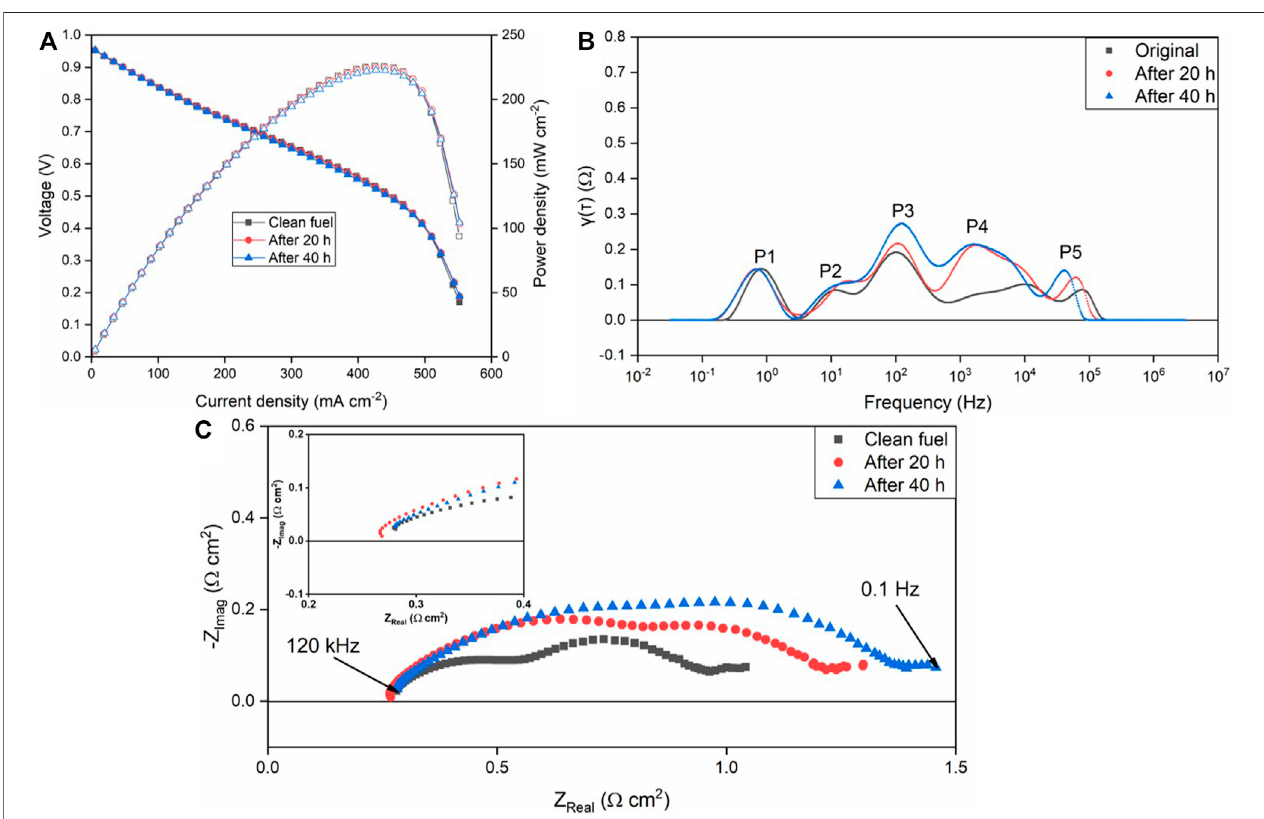
FIGURE3| PerformancedegradationoftheSOFCduetoL4contamination withH 2 +N 2 +L4asthefuelat750 ° C. (A) polarizationcurve; (B) EISmeasurements; (C) DRT plot.